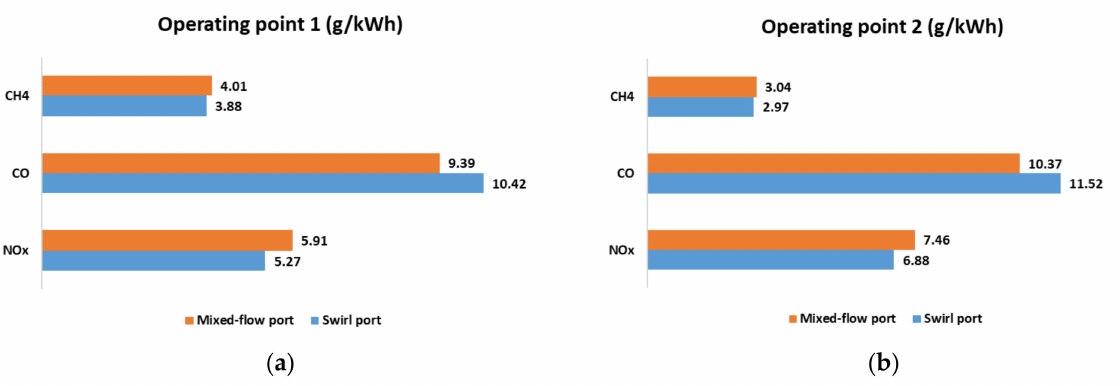
Figure 7. The comparison of NO x , CO, and HC of the two intake ports under ( a ) operating point 1 and ( b ) operating point